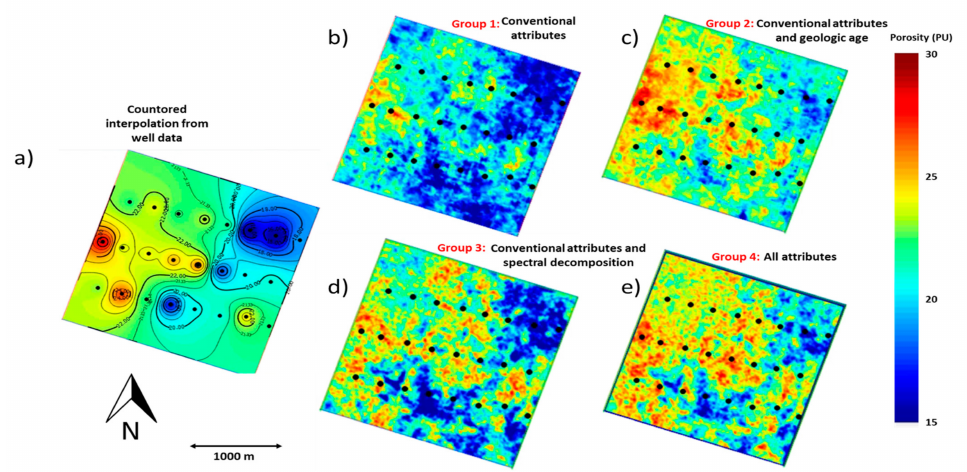
Figure 11. ( a ) Interpolation of the average porosity over a 20-ms window below the main reservoir top shown in Figure 10. ( b ) Group 1 map of average porosity over a 20-ms window below the main reservoir seismic pick in Figure 10. ( c ) Group 2 map of average porosity over a 20-ms window below the main reservoir seismic pick shown in Figure 10. ( d ) Group 3 map of average porosity over a 20-ms window below the main reservoir seismic pick shown in Figure 10. ( e ) Group 4 map of average porosity over a 20-ms window below the main reservoir seismic pick shown in Figure